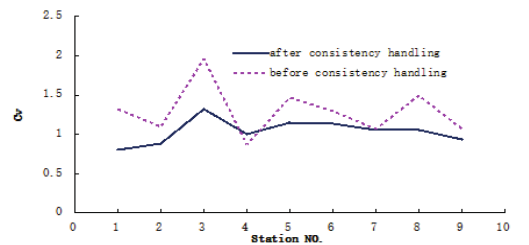
Fig. 5 The variation of Cv in homogeneous region.